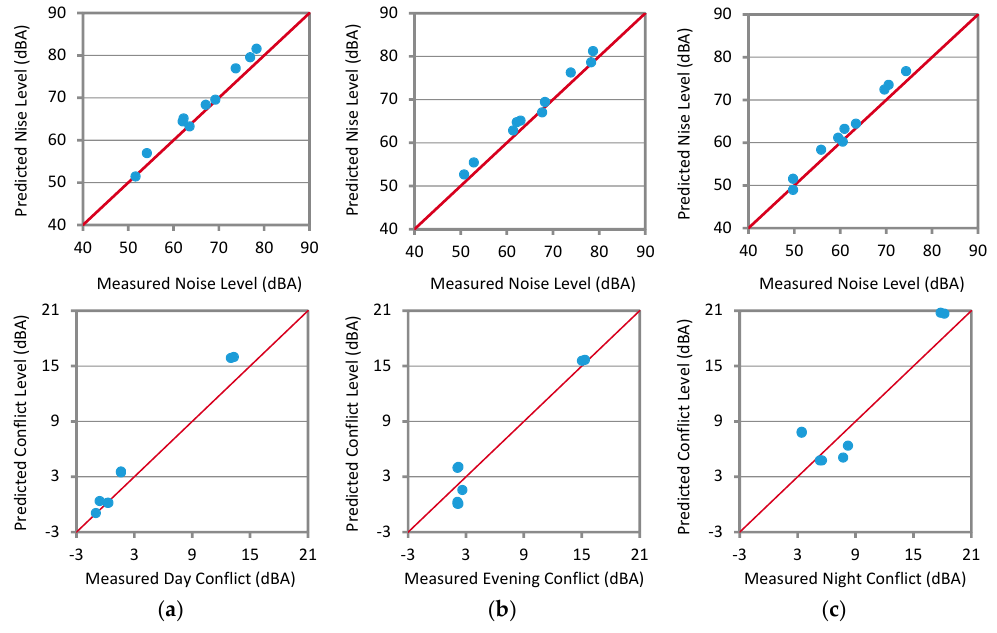
Figure 7. Predicted vs. measured noise levels ( upper figures) and façade conflict levels ( lower figures). Points: actual correlation; Straight lines: 100% agreement. ( a ) Daytime levels; ( b ) Evening time levels; ( c ) Nighttime levels.